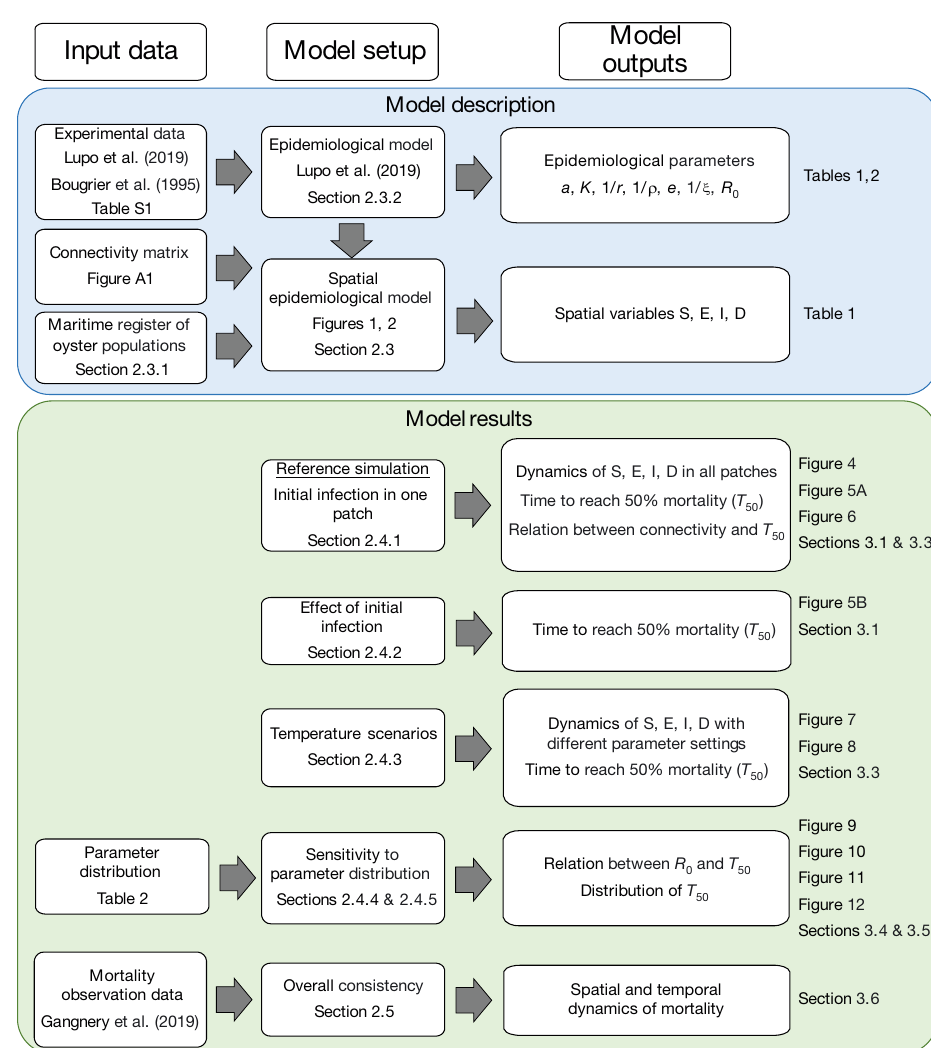
Fig. 3. Model workflow: input data, model setup, and outputs with corre- sponding sections, val- ues, and results in the main